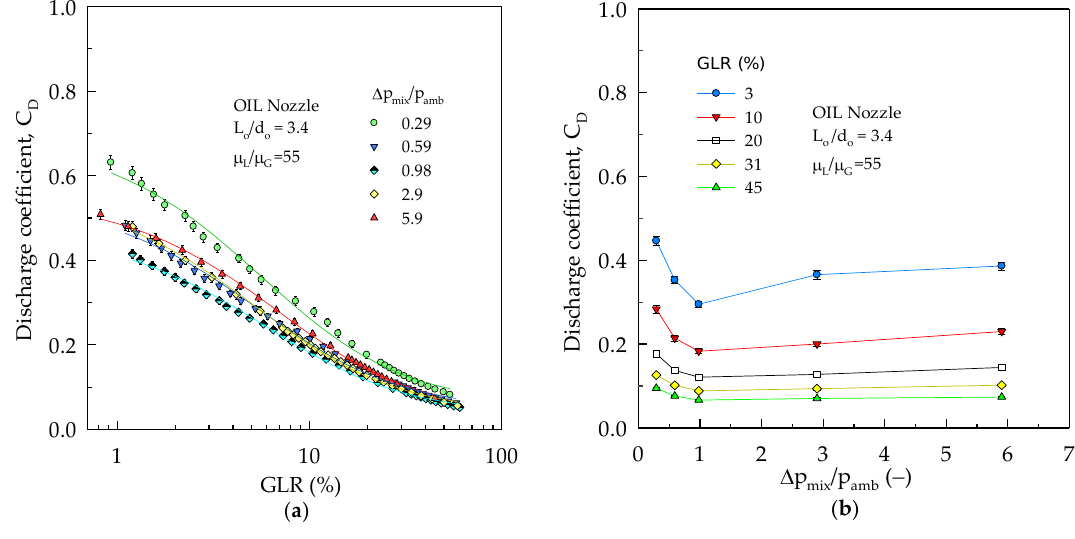
Figure 5. The effect of ( a ) GLR on C D at different ∆p mix /p amb values and of ( b ) ∆p mix /p amb on C D at Figure 5. The e ff ect of ( a ) GLR on C D at di ff erent ∆ p mix / p amb values and of ( b ) ∆ p mix / p amb on C D at different GLRs. di ff erent GLRs.